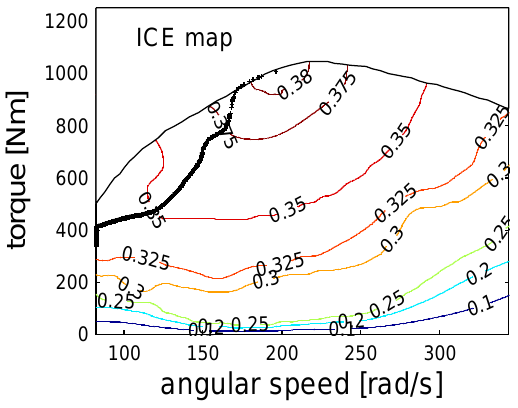
Figure 9. Engine usage map.